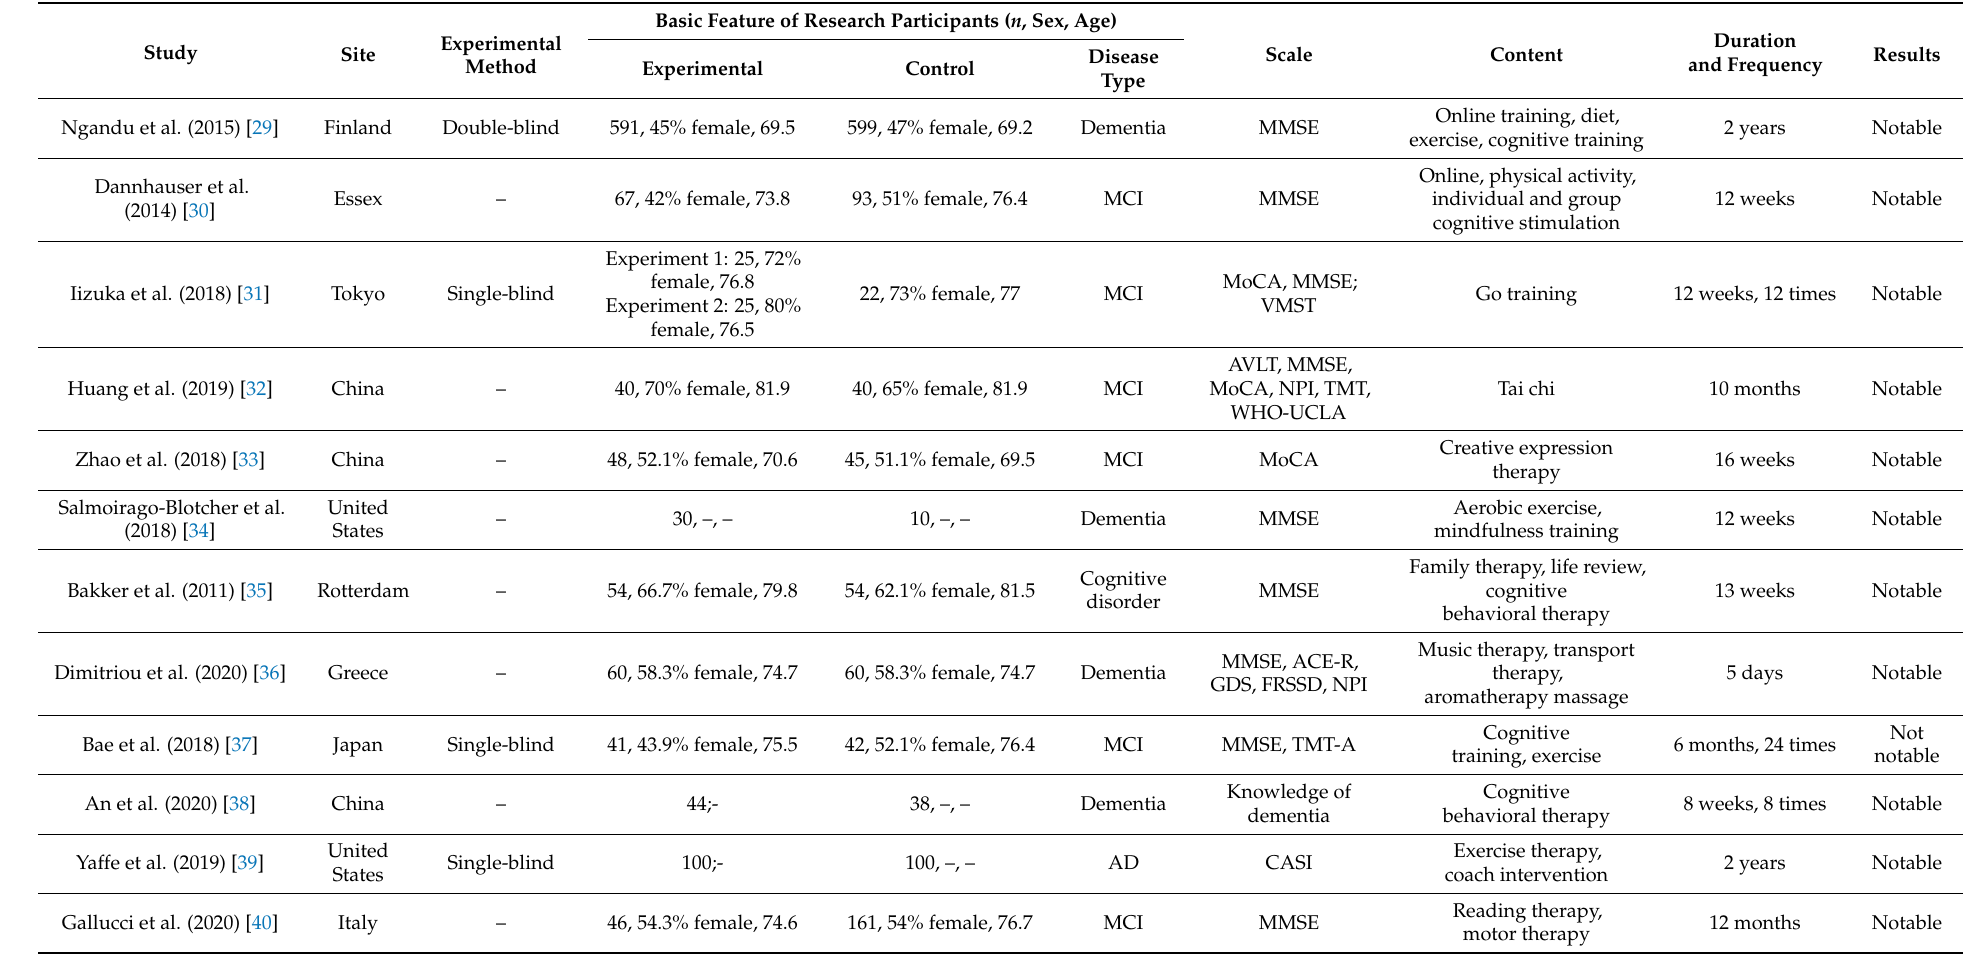
Table 1. Basic information of included